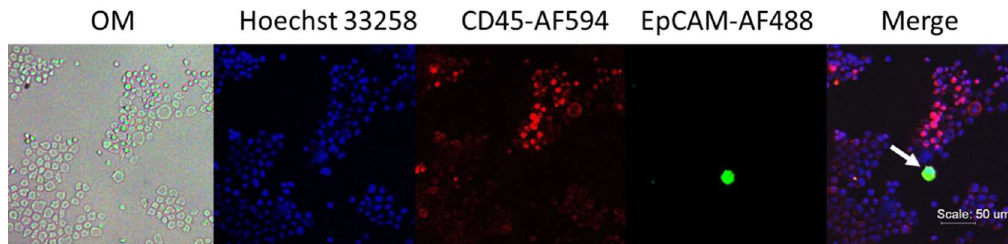
Figure 1. Phenotypic analysis in spike-in samples. The HCT116–leucocyte suspension at 1:1,000,000 dilution was prepared into a monolayer with a self-assembled cell array (SACA) chip and was stained with anti-epithelial cell adhesion molecule (EpCAM) conjugated with fluorescein isothiocyanate (FITC), anti-cluster of differentiation 45 (CD45)-AF594, and Hoechst 33258. The target cell is marked with a white arrow.